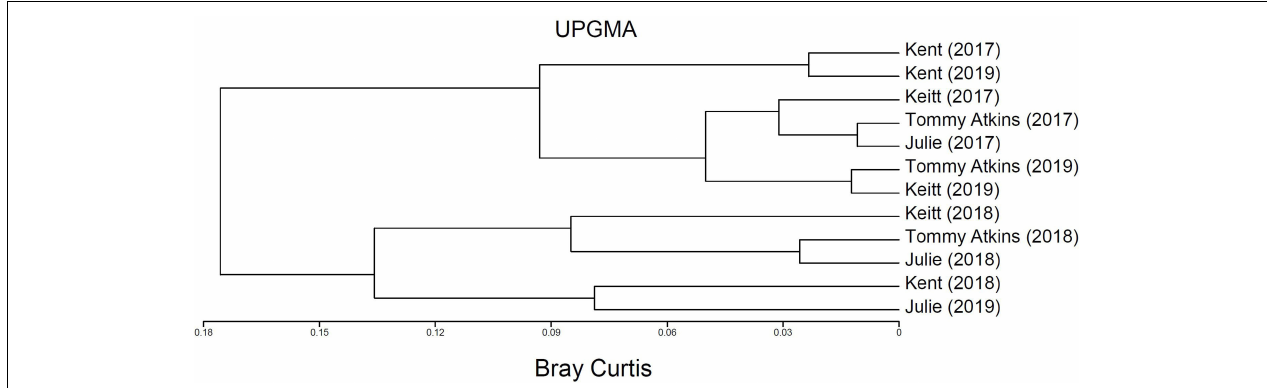
FIGURE 4 | Dendogram depicting multivariate clusters using Bray Curtis dissimilarity index based on total insect species richness, total abundance, and abundances of each of the three dominant insect pollinators of M. indica ( Palpada vinetorum, Apis mellifera , Cochliomyia minima ) recorded for four fields (Julie, Keitt, Kent, Tommy Atkins) in 2017, 2018, and 2019 at the Juana Diaz Experimental Station in Puerto